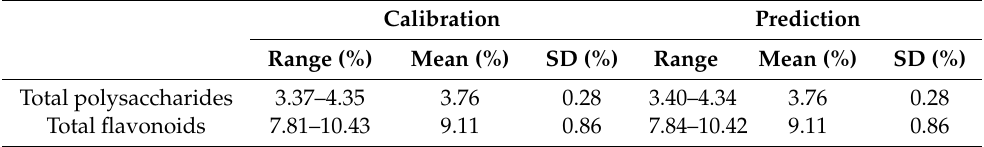
Figure 2. Statistical analysis of total polysaccharides content and total flavonoids content in Chrysanthemum morifolium : ( a ) total polysaccharides; ( b ) total flavonoids. The letters a, b, c in the figures indicate the results of significant analysis of small flowers, medium flowers, and big flowers. Table 1. Statistical summary of samples in the calibration set and the prediction set.